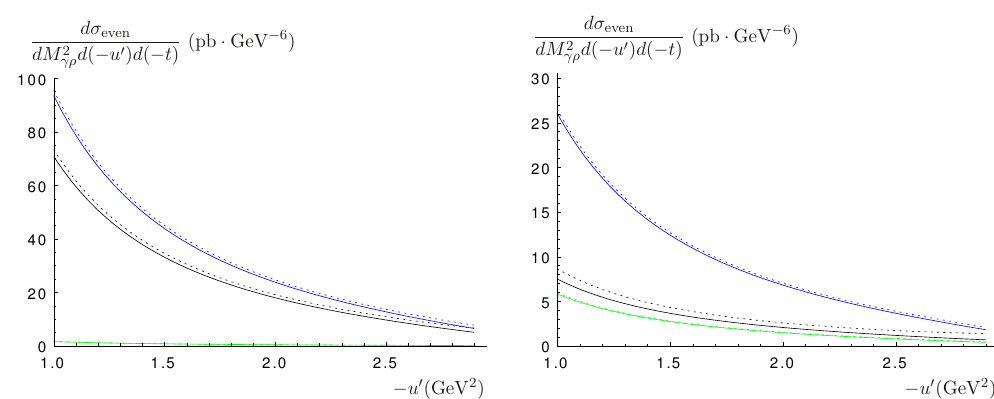
Figure 6 . Differential cross section for a photon and a longitudinally polarized ρ meson production, for the proton (left) and the neutron (right), at M 2 = 4 GeV 2 . Both vector and axial GPDs are γρ included. In black the contributions of both u and d quarks, in blue the contribution of the u quark, and in green the contribution of the d quark. Solid: “valence” model, dotted: “standard” model.